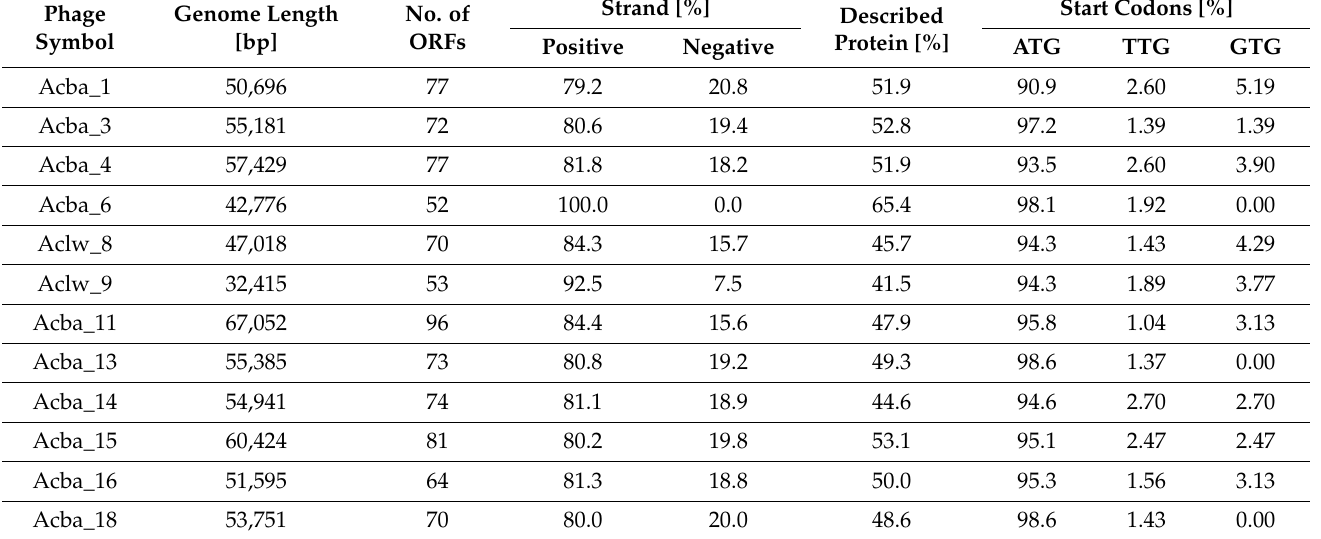
Table 6. Basic features of sequenced phages.